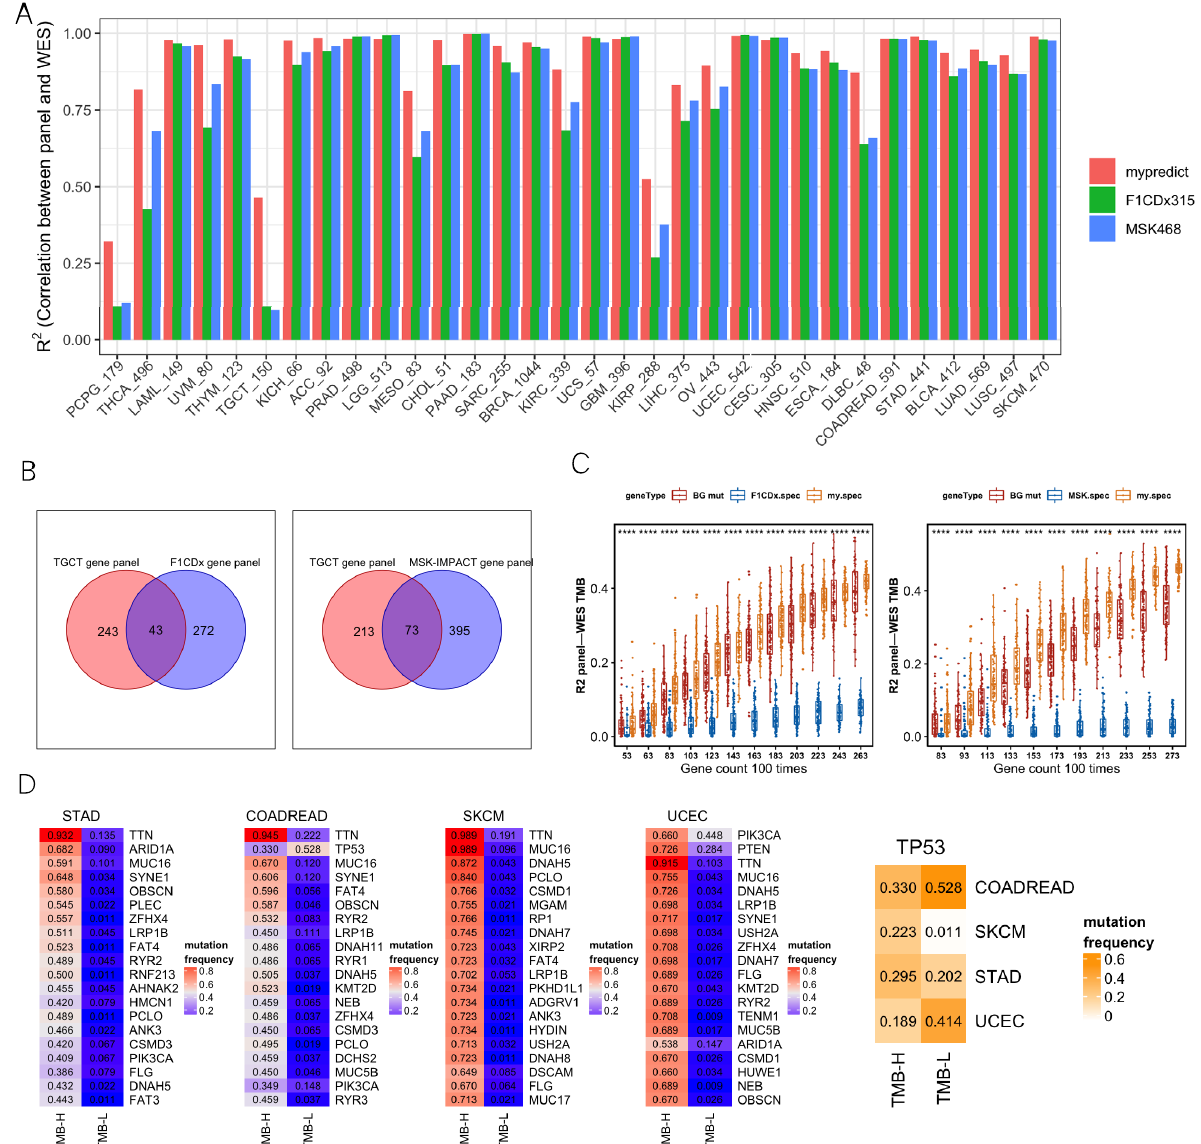
Figure 2. ( A ) R 2 between gene panel TMB and WES TMB across 32 cancer types. SepPanel (red bar), F1CDx (green bar), and MSK (blue bar). ( B ) Venn plots of TGCT-SepPanel with F1CDx (left), TGCT-SepPanel with MSK (right) gene sets. ( C ) The boxplot on the left panel represents R 2 between gene panel TMB and WES TMB across TGCT-SepPanel (orange boxplot), random gene panel (red boxplot), and F1CDx gene panel (blue boxplot). The boxplot on the right panel represents R 2 between gene panel TMB and WES TMB across TGCT-SepPanel (orange boxplot), random gene panel (red boxplot), and MSK gene panel (blue boxplot). ‘****’ means Wilcox test p value < 0.0001. The dots out of box are outliers. Q1 and Q3 represent top and bottom quantile of data batch. Lower limit is Q1-1.5(Q3-Q1). Upper limit is Q3+1.5(Q3-Q1). Outliers are the data out of range (lower limit to upper limit). ( D ) The four heatmaps on the left panel represent the top 20 differentially mutated genes among high- and low-TMB group in STAD, COADREAD, SKCM, and UCEC. The heatmap on the far right represents TP53 mutation frequency of high- and low-TMB group in these four cancer types. The numbers in the heatmap represent mutation frequencies in these